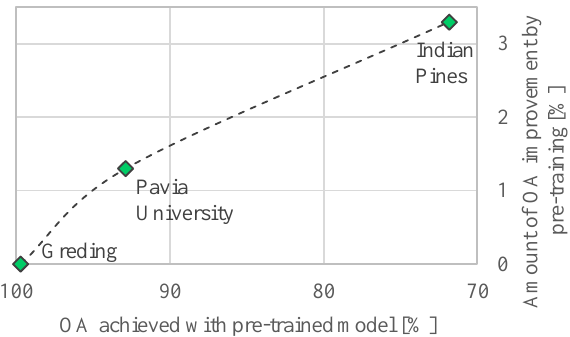
Figure 5. Comparison of the OA achieved for the classification of the three benchmark datasets and the OA improvement achieved by using the pre-trained